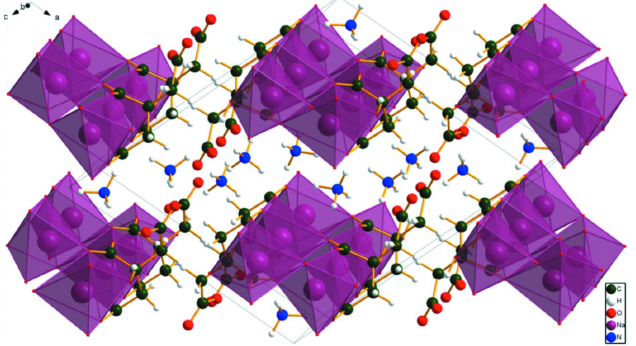
Figure 10 Comparison of the X-ray powder diffraction patterns of (II) (green) and (NH 4 ) 2 KC 6 H 5 O 7 (black).